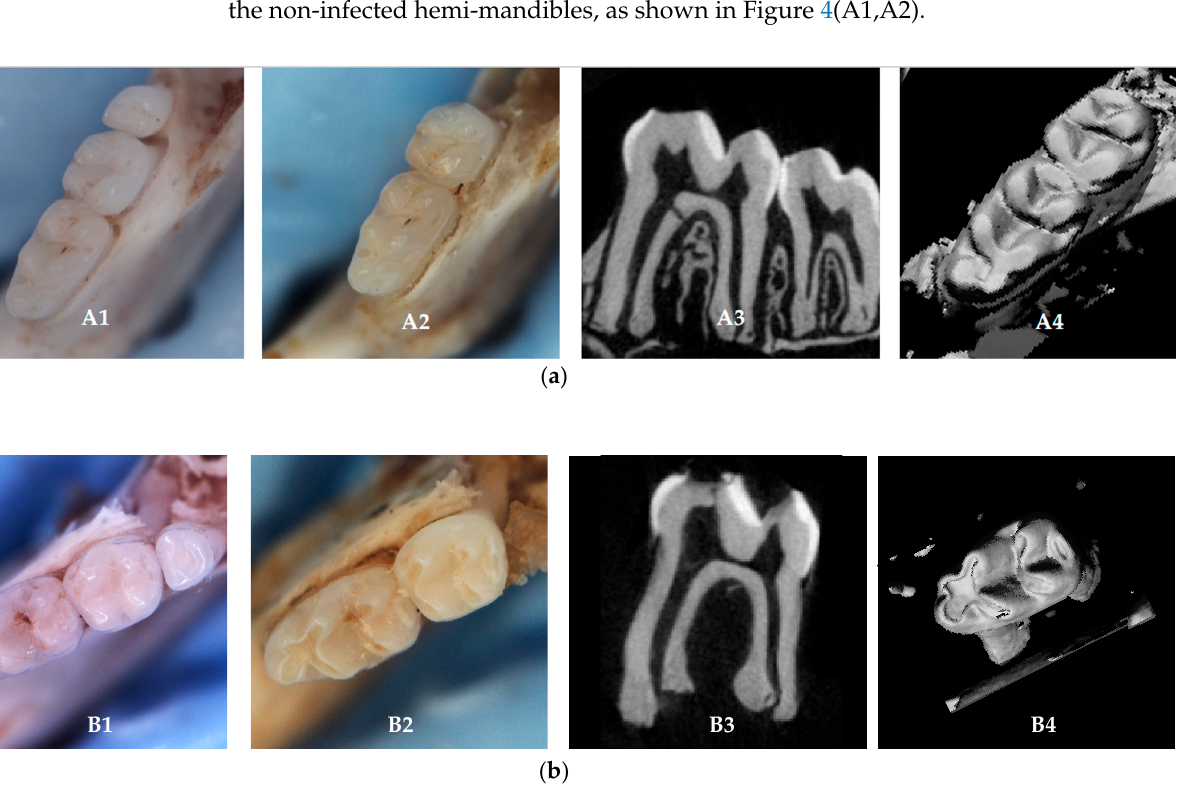
Figure 4. Evaluation of caries lesions, clinical and radiographic, after 5 days in a caries-promoting environment . Rep- resentative clinical and radiographic images. ( a ) represents the no bacteria group; ( b ) represents the S. mutans UA159 bacterial-infected group. Clinical photos were depicted before ( A1 , B1 ) and after ( A2 , B2 ) caries induction using high-sucrose media and cariogenic bacteria ( S. mutans UA159 ) for 5 days. Radiographic ( A3 , A4 ) scans were used for demineralization evaluation and quantification; hemi-mandibles were segmented and reconstructed to acquire 3D images by the µ CT ( A4 , B4